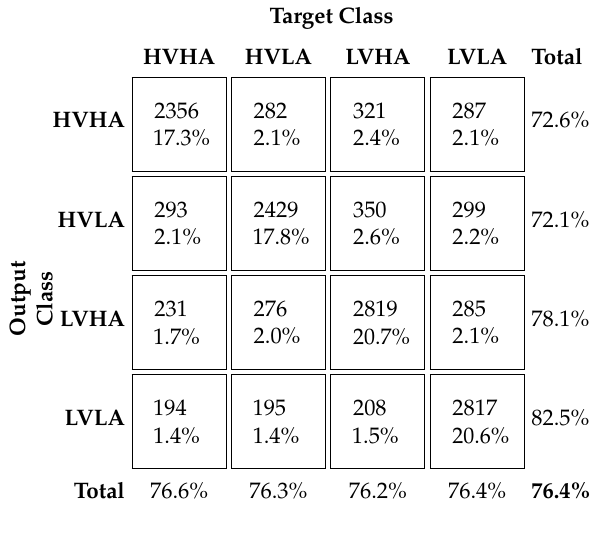
Table 12. Confusion matrix of EEG modality for AMIGOS